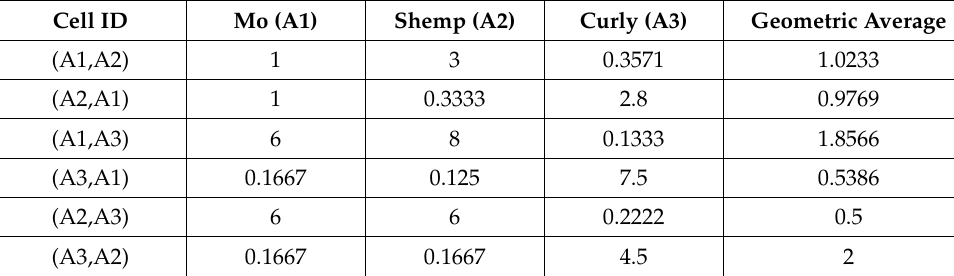
Table 21. Geometric Average for Non-diagonal Entries in Tables 18–20.